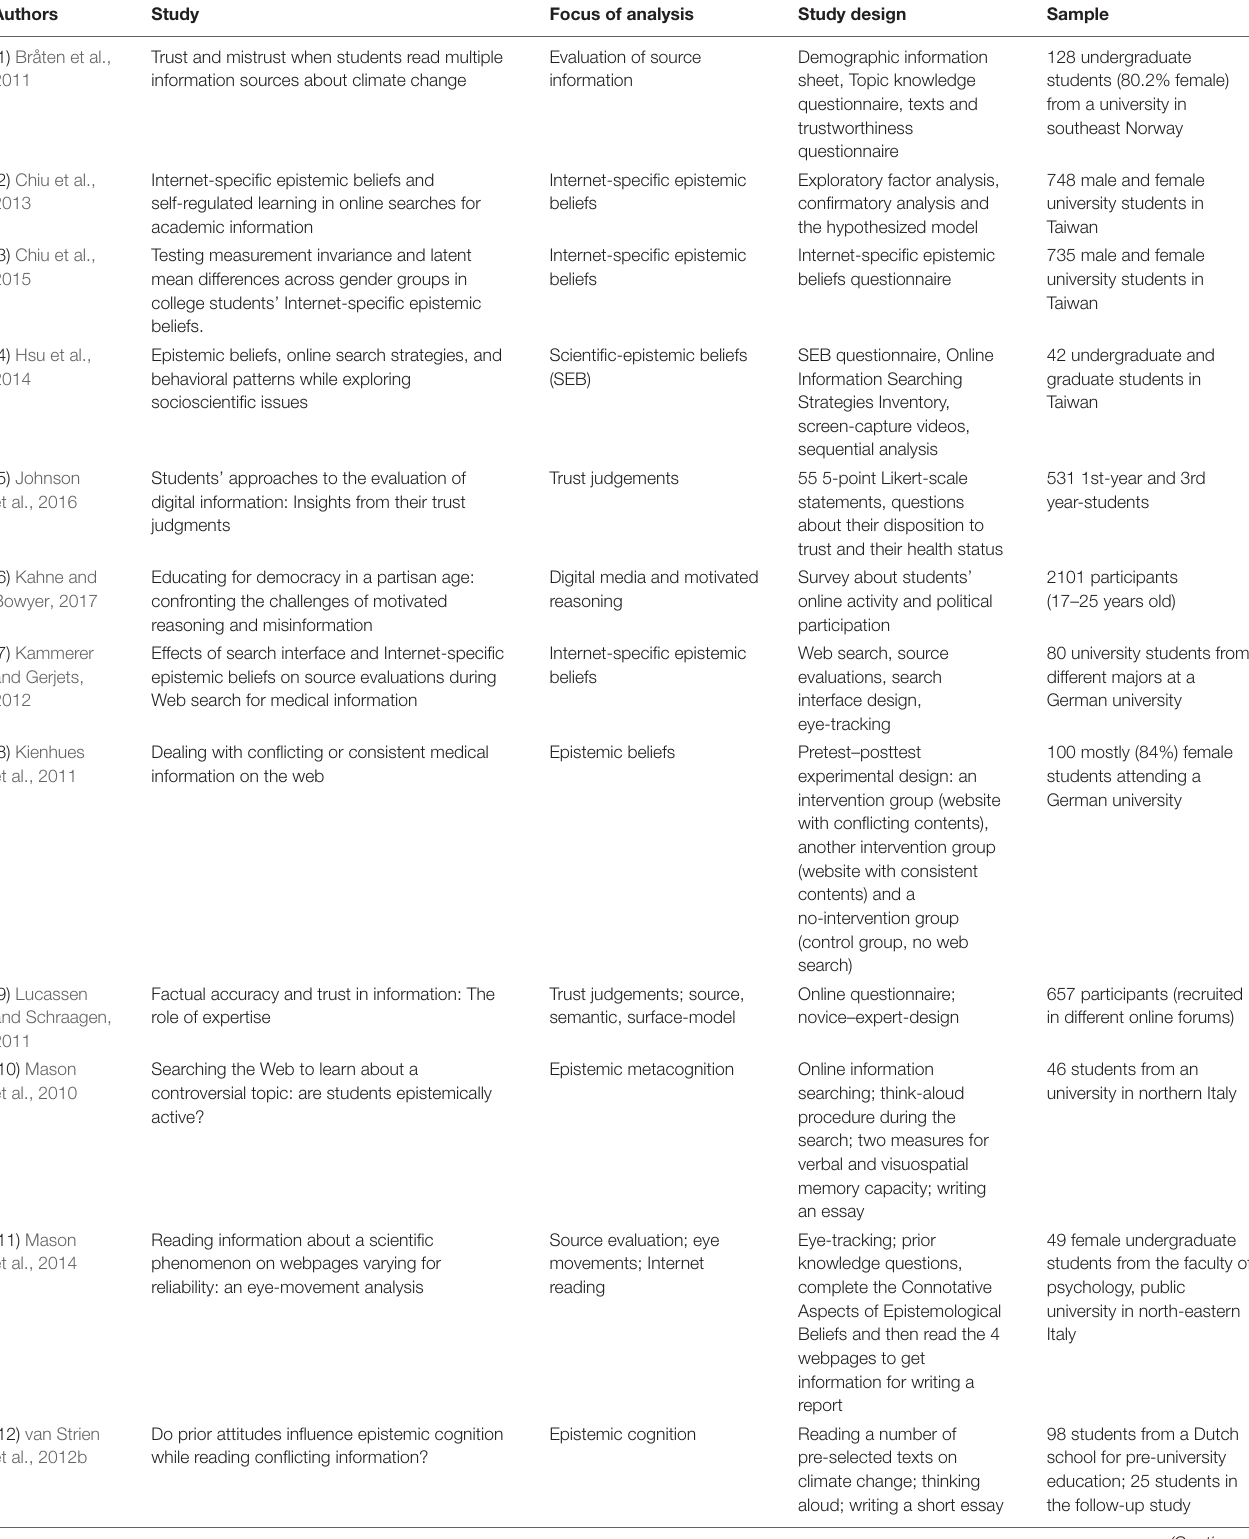
TABLE 1 | Overview of recent studies on beliefs and their impact on information